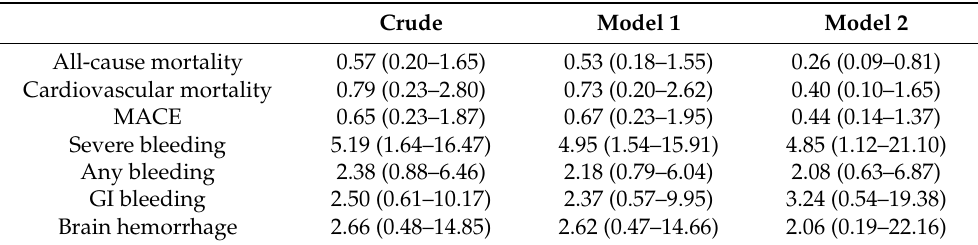
Table 3. Comparison of warfarin anticoagulation and no